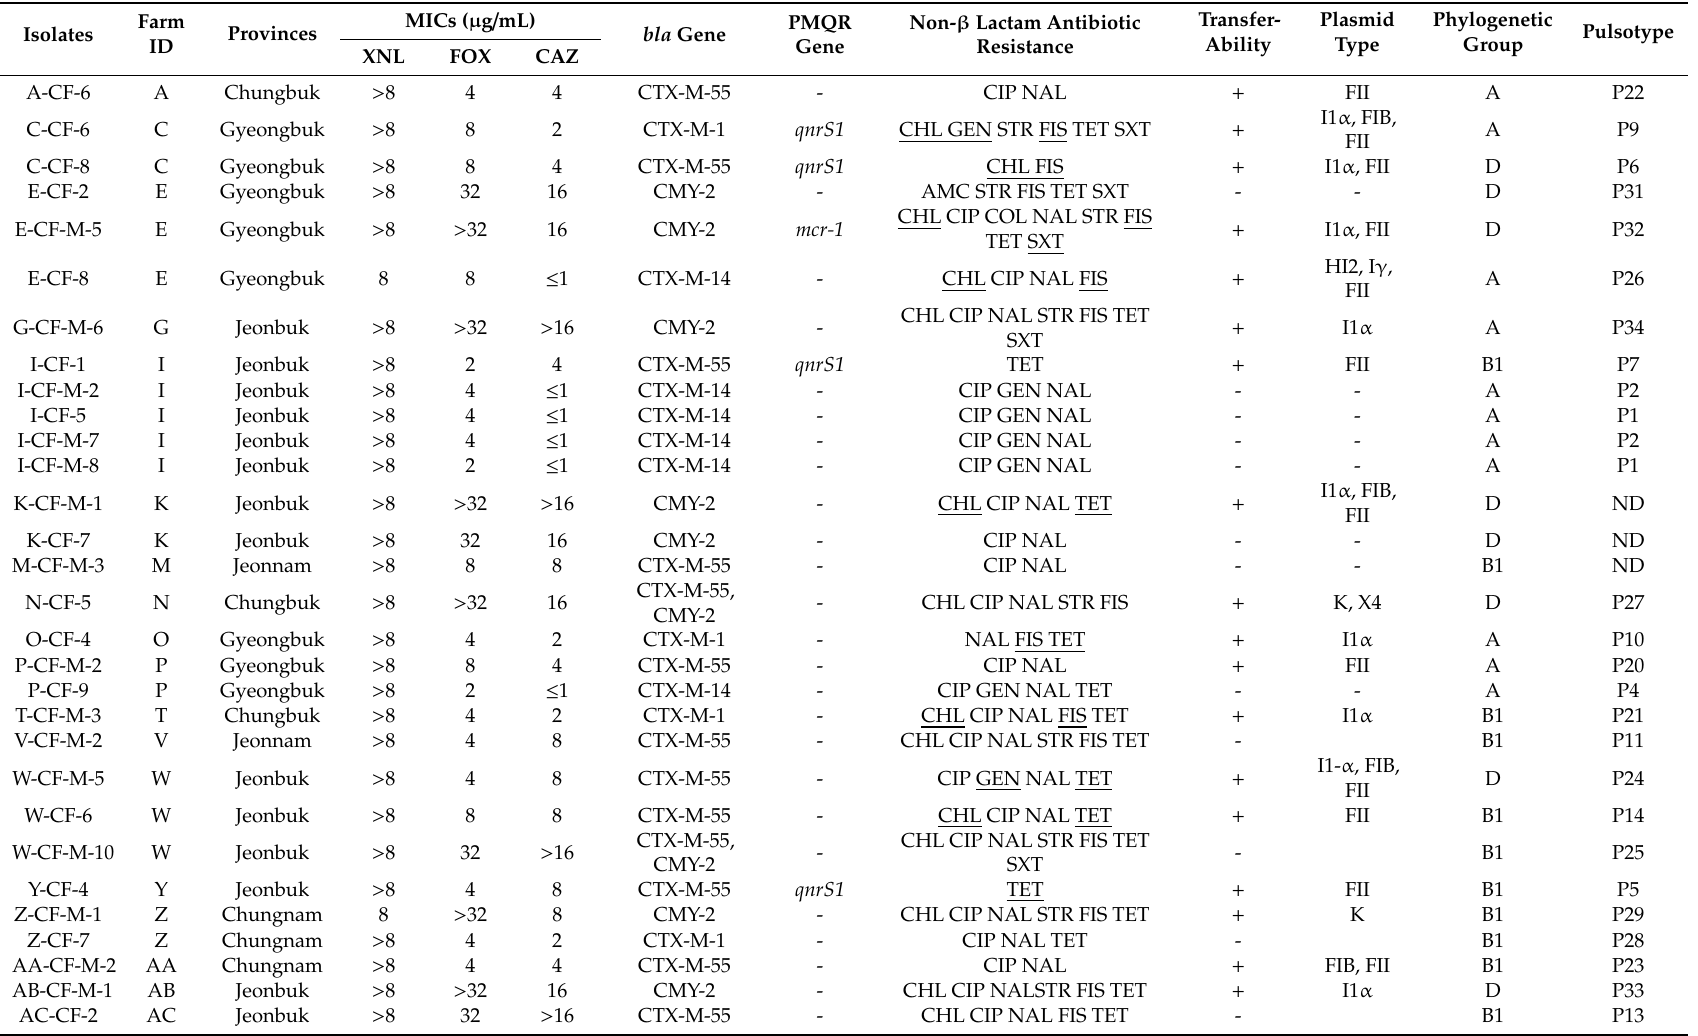
Table 4. Characteristics of ESBL / pAmpC-producing Escherichia coli isolated from healthy broiler chickens in